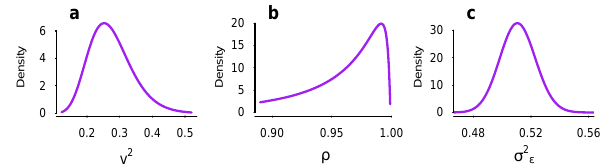
Figure4. Plotsofthesmoothedposteriordistributionsof (a) thevarianceoftheunitincrementoflatentprocess Figure 4. Plots of the smoothed posterior distributions of (a) the x , (b) crosscorrelationcoefficientand (c) nuggeteffectforGRIP(nuggeteffectforGISPisdirectlyproportional variance of the unit increment of latent process x , (b) the cross- tothis).TheseareresultsbasedonthejointmodeldiscussedinSect.3.1appliedtoGISP2andGRIP. correlation coefficient and (c) the nugget effect for GRIP (the nugget effect for GISP is directly proportional to this). These are results based on the joint model discussed in Sect. 3.1 applied to GISP2 and